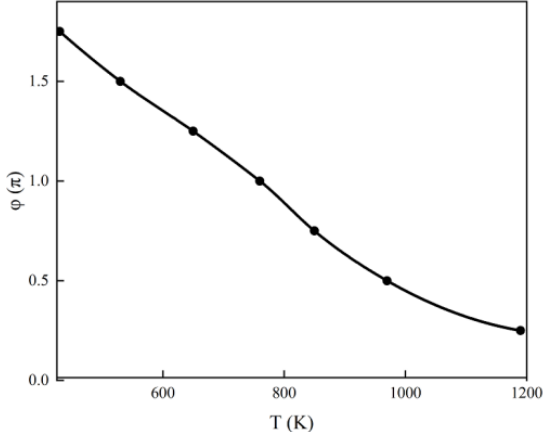
Figure 5. The delay of acoustic phase corresponding to temperature. The function of Equation (5) was drawn, using the Origin drawing software. Seven kinds of transmission units with different temperatures corresponded to seven kinds of phase delays of acoustic waves. The distribution of transmission units is shown in Figure 6.